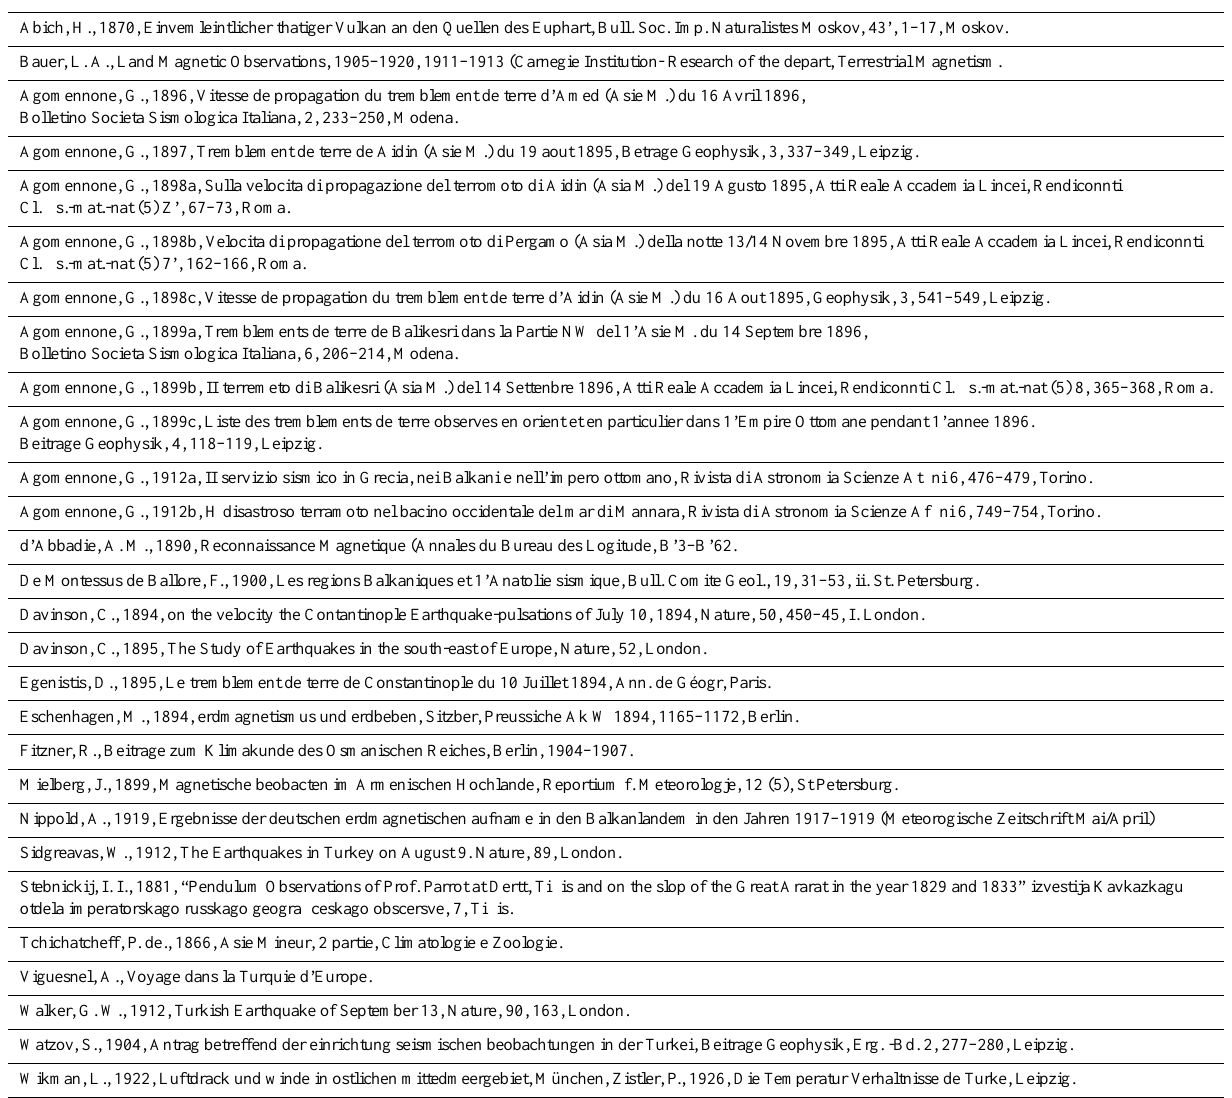
Table 3. Some geophysical books and papers on Turkey before 1920 (the historical period) written by several researchers (after Sipahioglu, 1957; Çölasan, 1960; Akyol, 1940; Brinkman,